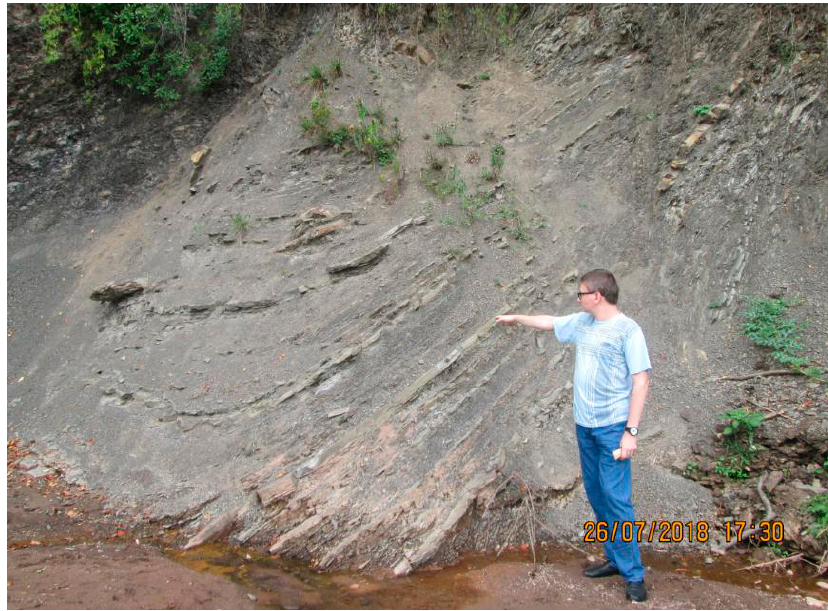
Figure 1. Small fold (left) and thrust (right) in the Khamyshki-Lipovaja geosite (photo by N.V. Ruban).